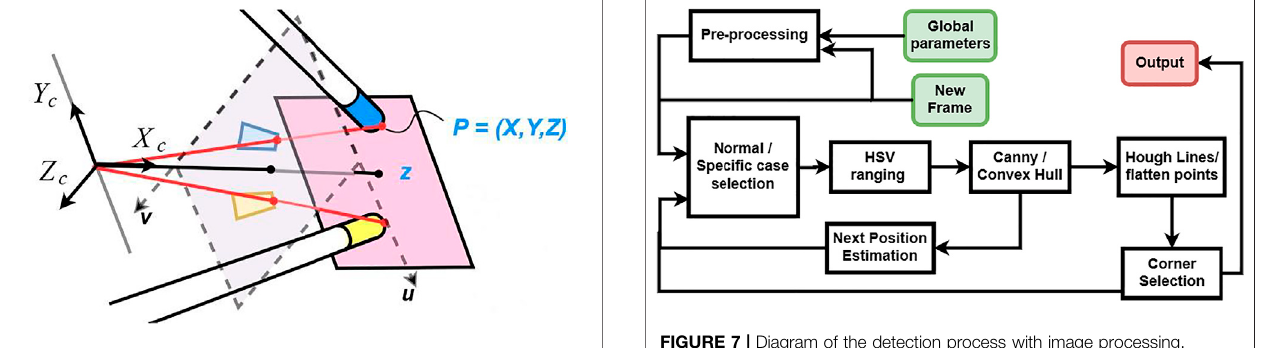
FIGURE 5 | Representation ofthe trapezoidal shapes after fl attening the view of the cylinders and the angle of the instruments regarding the camera.